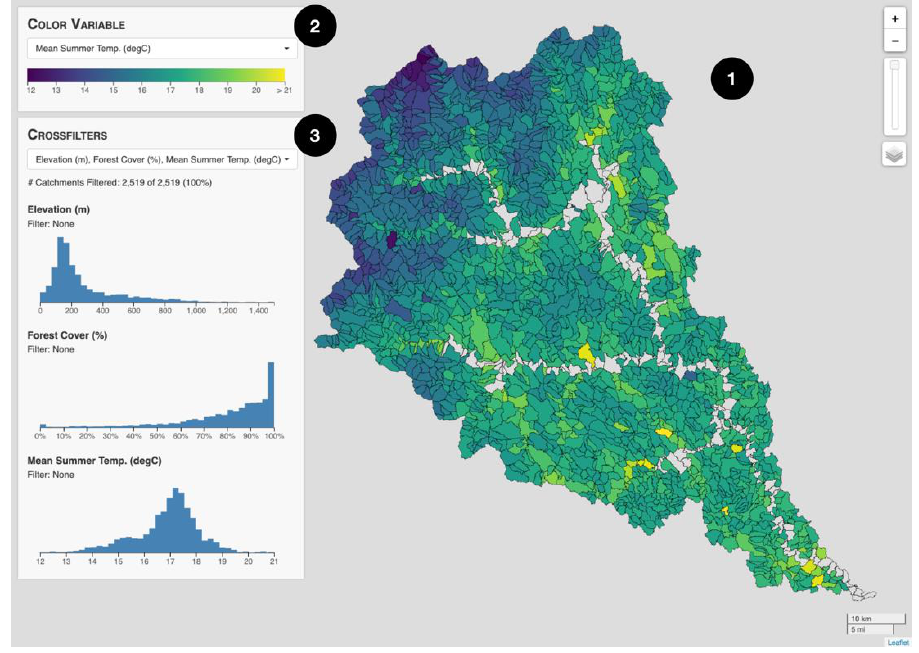
Figure 2. Screenshot of a simplified Interactive Catchment Explorer (ICE) application containing (1) a map showing the mean summer stream temperature of catchments within the Saco River watershed, Maine; (2) a selection menu for choosing the color variable; and (3) crossfilters showing histograms for the elevation, percentage of forest cover and mean summer stream temperature of the catchments.